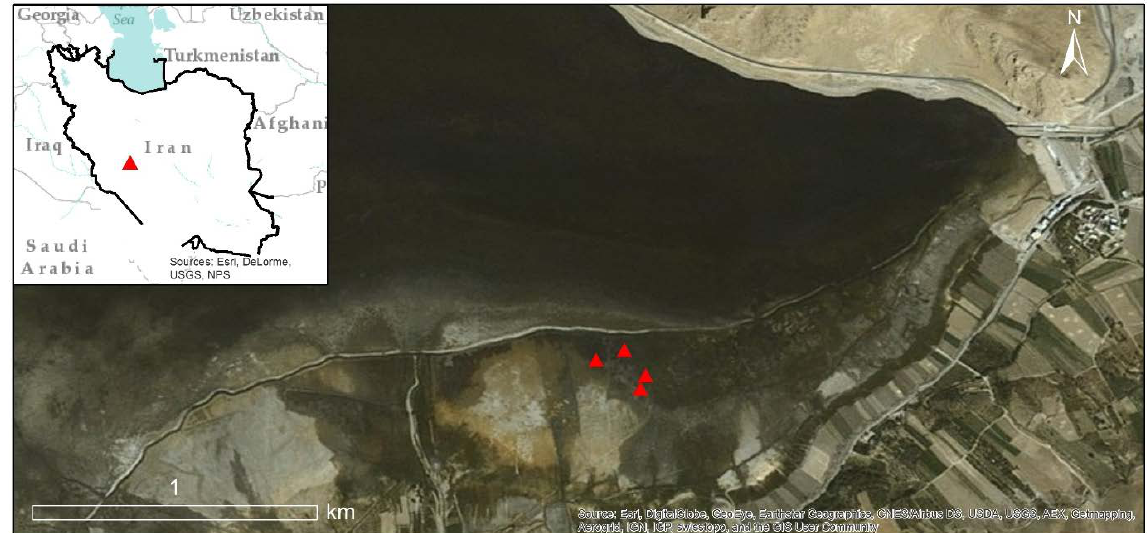
Figure 1. Main panel: peat sampling locations (red triangles) superposed on ESRI World Imagery of the eastern end of Chaghakhor Wetland. Inset: location of Chaghakhor Wetland (red triangle) within Iran; basemap from ESRI World Reference Overlay, country boundary from MapCruzin ‘Iran administrative’ data (Creative Commons Attribution Share-Alike 2.0, www.openstreetmap.org and